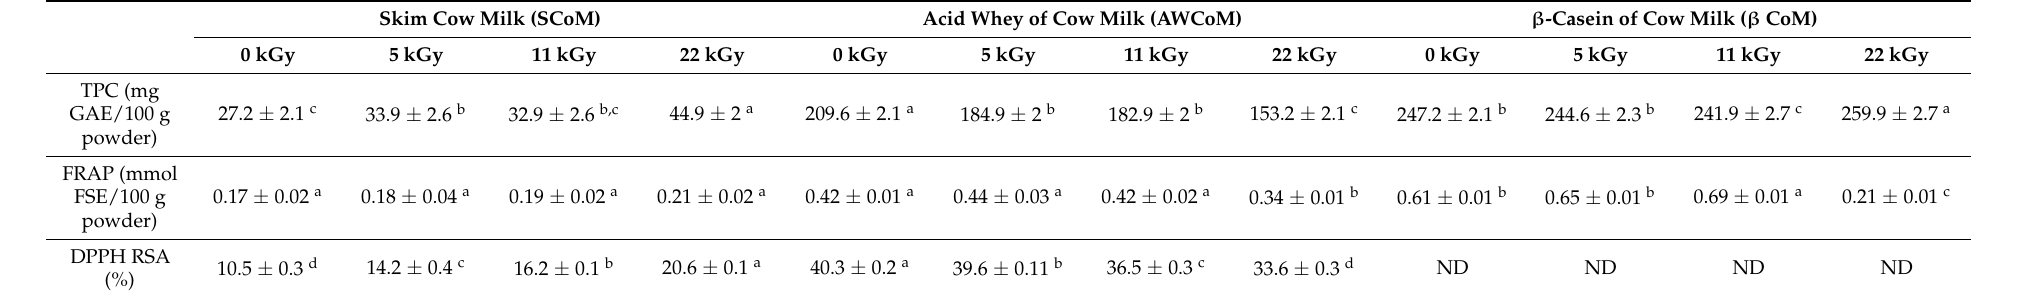
Table 1. Total phenolic contents and antioxidant activity measured by FRAP and DPPH assays, in extracts of irradiated freeze-dried cow milk fractions. The results are presented as the mean ± standard error.